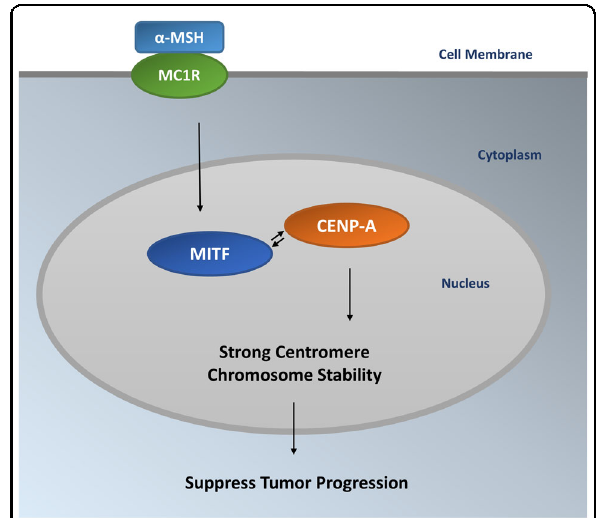
Fig. 6 MC1R is a protective factor in chromosome stability and centromere integrity in melanocytes. In human melanocytes, α - MSH binds MC1R and activates MC1R signaling, thus the expression of MC1R downstream factor MITF is stimulated. As a result, the enhanced interaction between MITF and CENP-A protects chromosome stability and reduces the risk of tumor